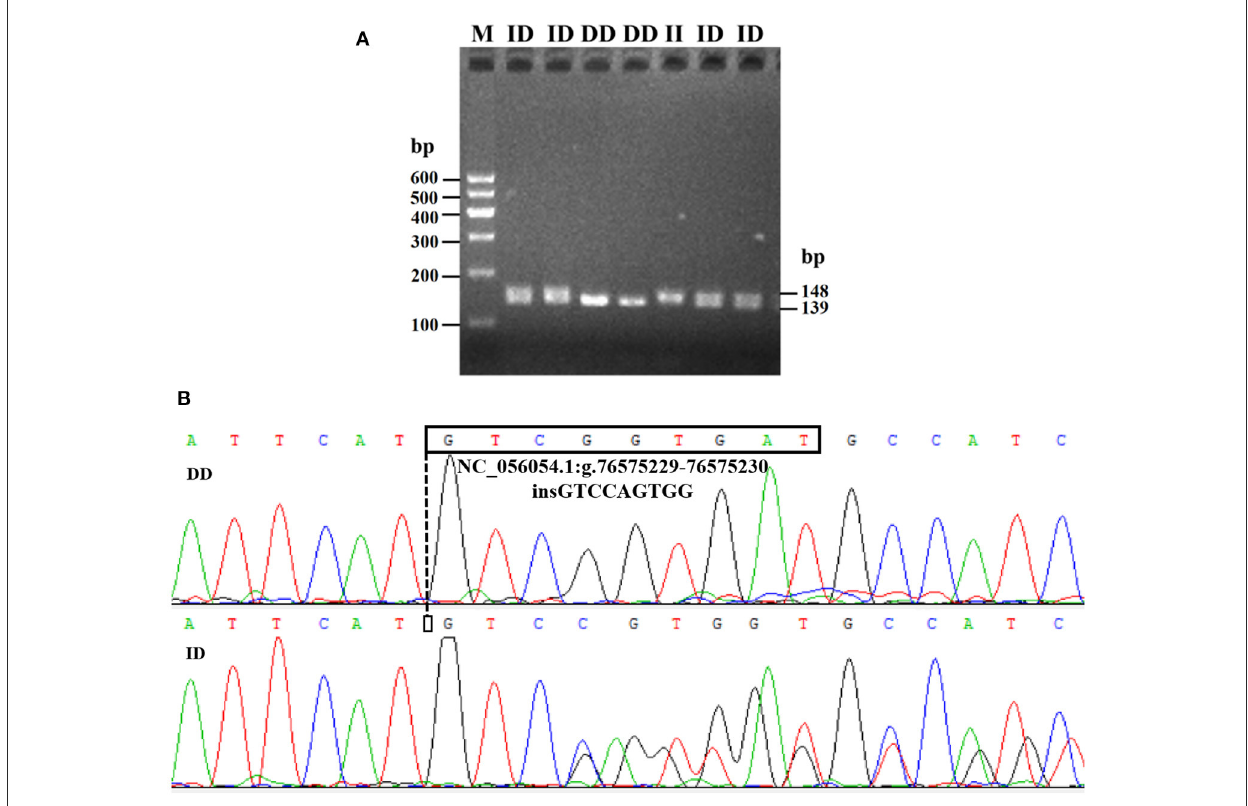
FIGURE3 Electrophoresis gel (A) and sequence chromatograms (B) of the P3-ins-9bp InDel within the ovine HIAT1